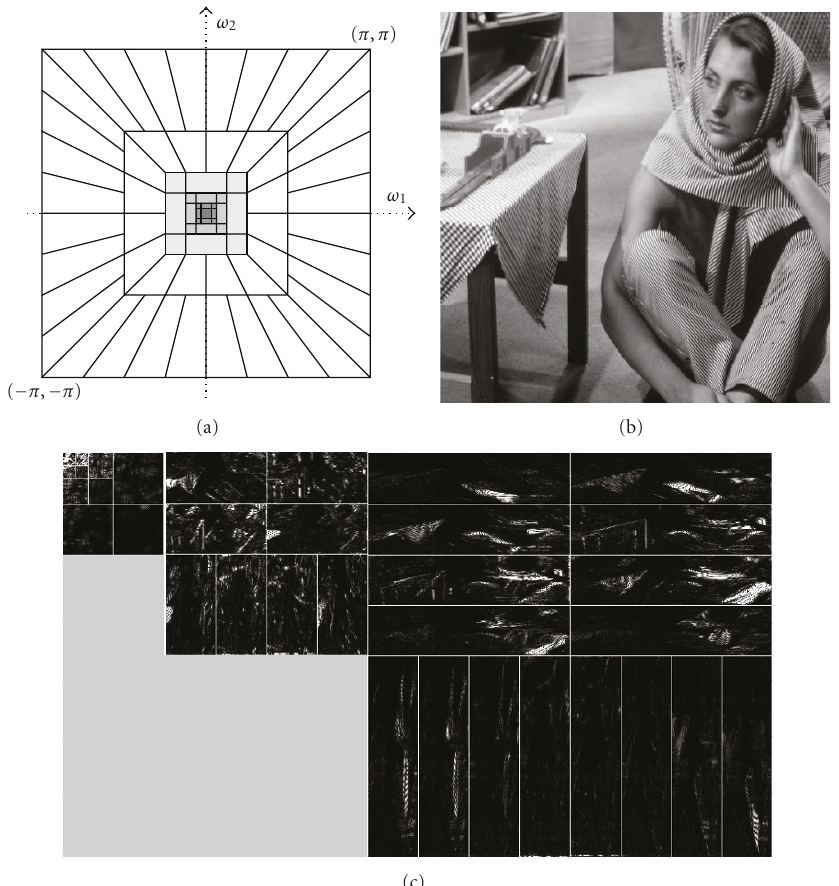
Figure 18: The PDFB employed in image coding. (a) The partitioning of the frequency plane by a hybrid PDFB and wavelet decomposition, (b) the Barbara testing image, and (c) the image representation by the five-level multiscale FB having the frequency supports in (a).